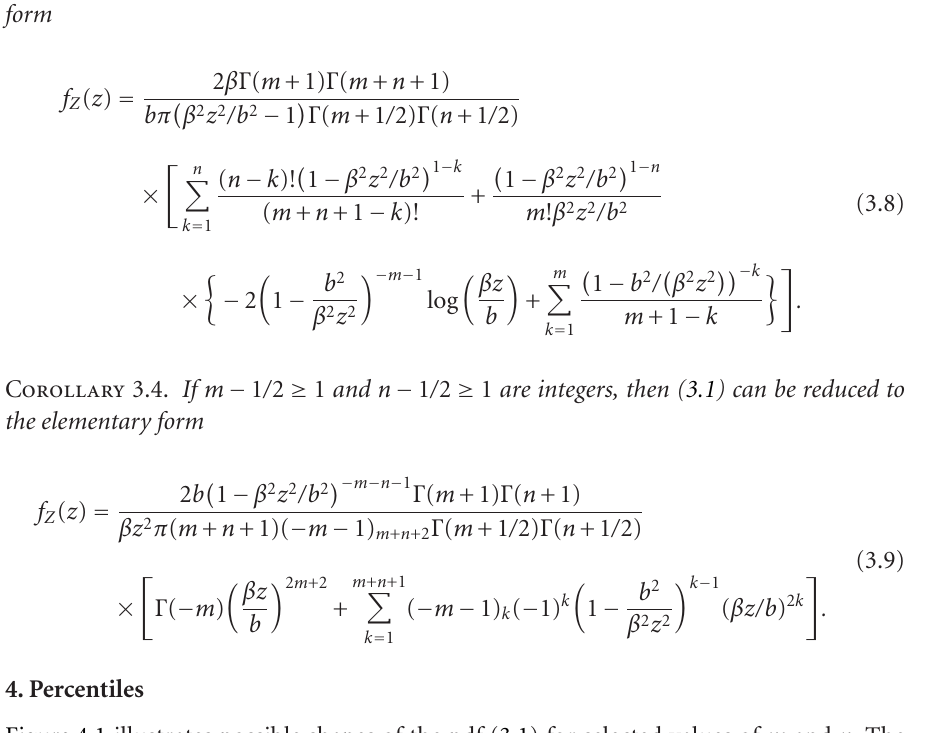
Figure 4.1 illustrates possible shapes of the pdf (3.1) for selected values of m and n . The four curves in each plot correspond to selected values of n . The e ff ect of the parameters is